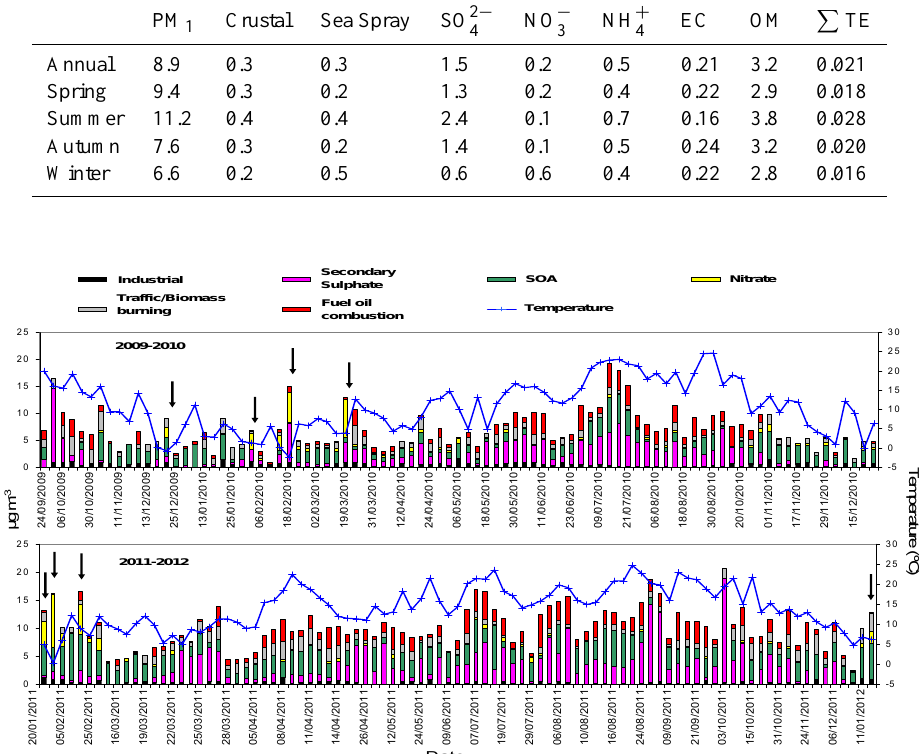
Fig. 4. Daily contribution of each source to total PM 1 mass concentration (µgm − 3 ) and temperature ( ◦ C) for 24/09/2009 to 19/12/2010 (above) and 20/01/2011 to 11/01/2012 (below). Intense winter pollution episodes are marked by black